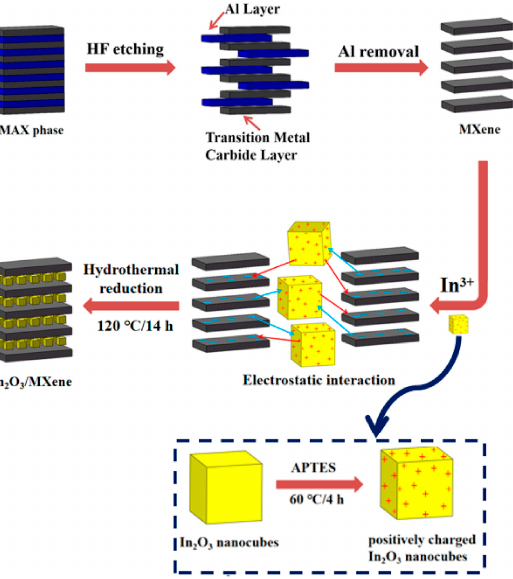
Figure 26. Scheme of In 2 O 3 /Ti 3 C 2 T x composites formation. Reprinted with permission from [133]. Copyright 2021: Elsevier B.V. Copyright 2021: Elsevier